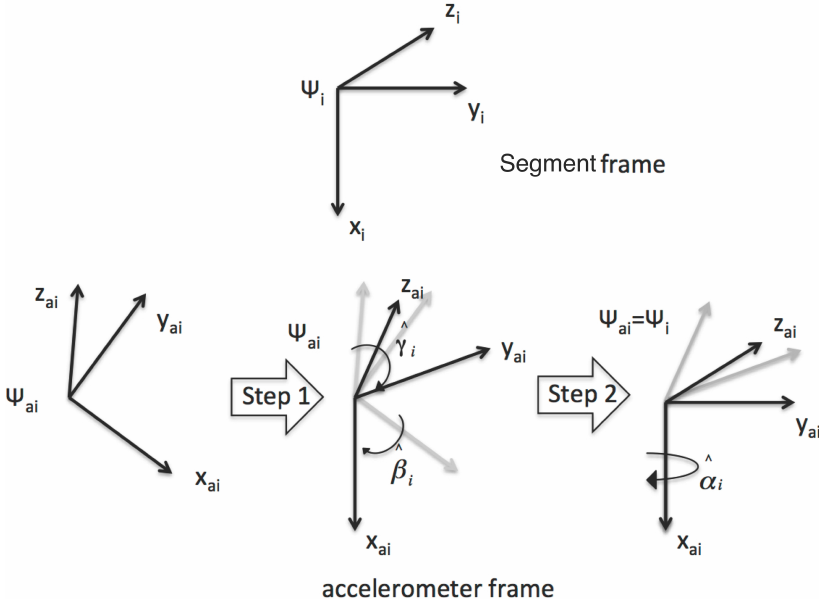
Figure 3. The calibration procedure for the accelerometers. In the first step, using the accelerometer output only, acquired from a subject in standing position, the x axes of ai the accelerometer frame are aligned with the corresponding x axis of the bone frames by i computing the ˆ γ and ˆ β angles. In the second step, using data collected by the goniometer i i and the accelerometers in a dynamic acquisition, the remaining axes of the inertial frames are aligned with the corresponding axes of the frames fixed with the joint